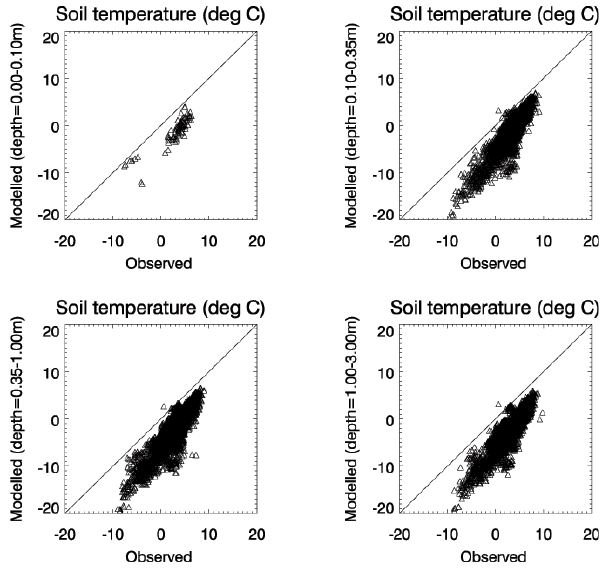
Fig. 3. Simulated and observed mean annual soil temperatures at Russian meteorological stations. Modelled soil temperatures are from the WATCH run (1958–2000) for the level indicated; obser- vations are from depths falling within each corresponding model